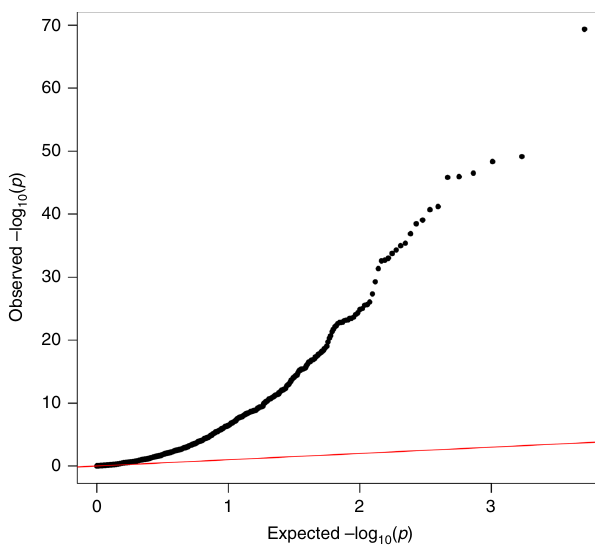
Fig. 3 Quantile-Quantile plot of − log10 p -values for factors in fl uencing being tested for COVID-19 in UK Biobank. The x -axis represents the expected p -value for 2556 hypothesis tests and y -axis represents the observed p-values. The red line represents the expected relationship under the null hypothesis of no